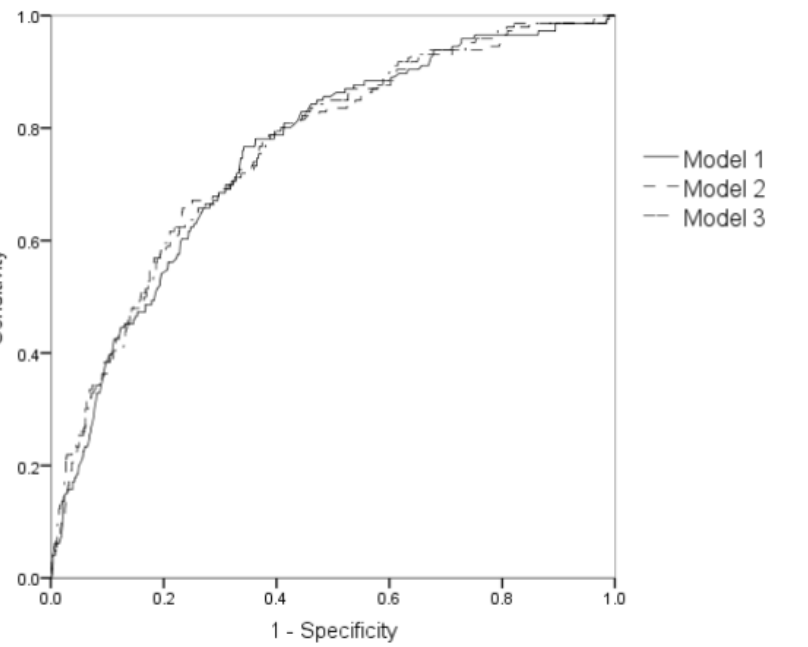
Figure 1. ROC curve of different statistical models. Models were built by logistic regression, variables contained in each model were as follows: Model 1: Age, sex, hyperlipidaemia, hypertension, smoking, and alcohol drinking behavior. Model 2: Variables in model 1 and rs184003 and rs4845625. Model 3: Variables in model 1 and PRS.